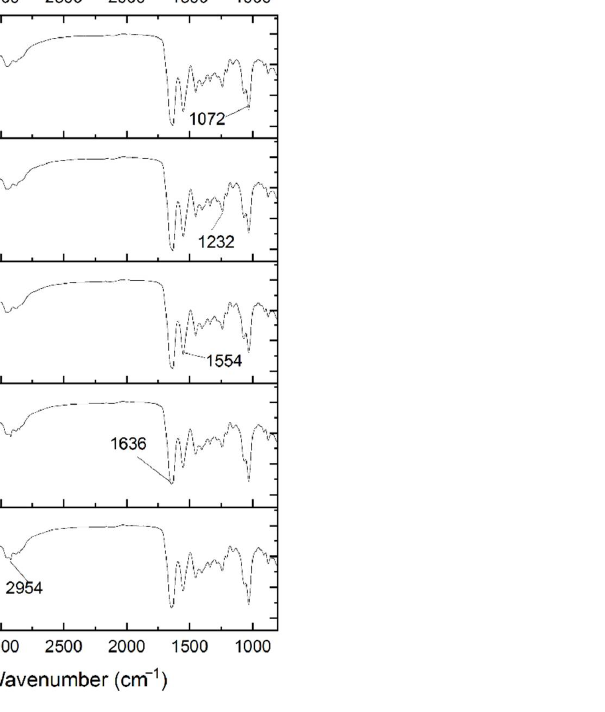
Figure 7. FTIR spectra of gelatin film formulations with different concentrations of silver nanoparticles.